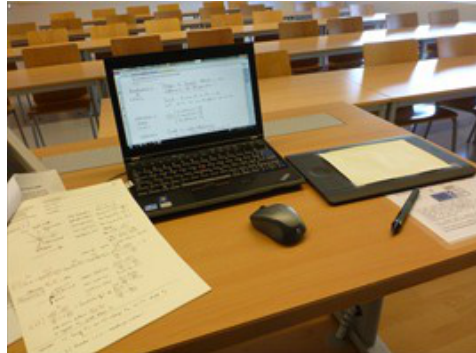
Figure 1. A typical arrangement to deliver a